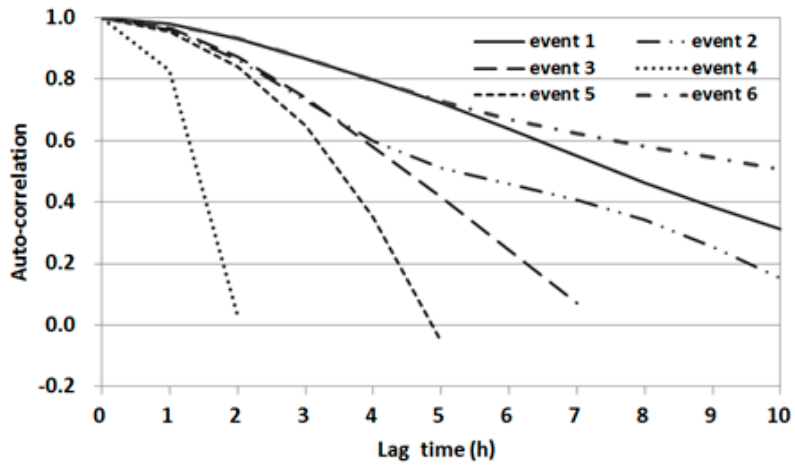
Figure 8. Auto-correlation of water level series at OG.